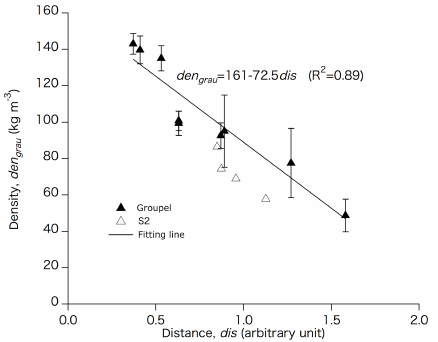
Figure 8. Relationship between snowfall density and distance of graupel group CMF (black triangle) from the fitted curve for lump graupel (illustrated in Fig. 7 by a solid line). The line and regres- sion equation show the approximated relationship. S2 group CMF (empty triangle) is also plotted, but is not included in the relation-